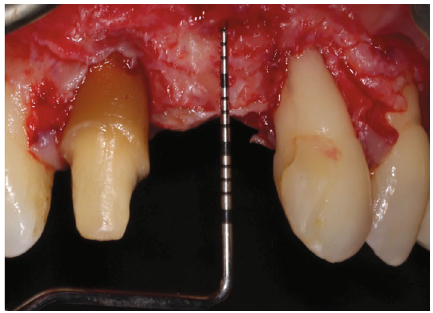
Figure 14: The previous connective tissue graft augmentation is evident after fl ap elevation.